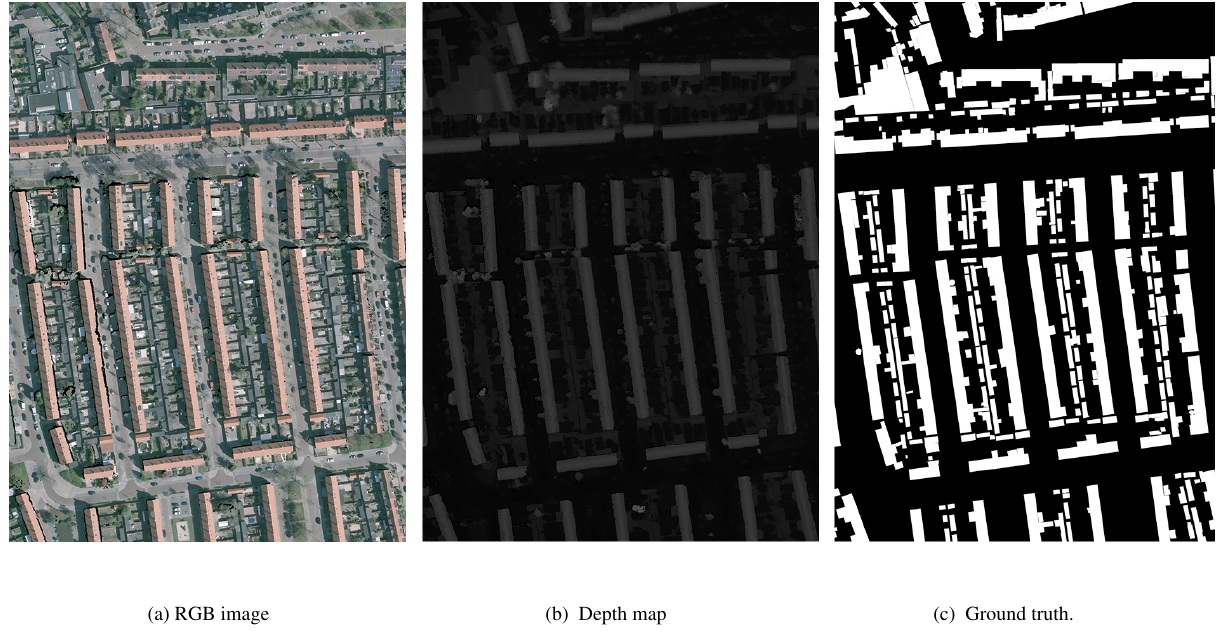
Figure 3. Example of an RGB-D input image (area of 250 × 340 meters) and its respective groundtruth.